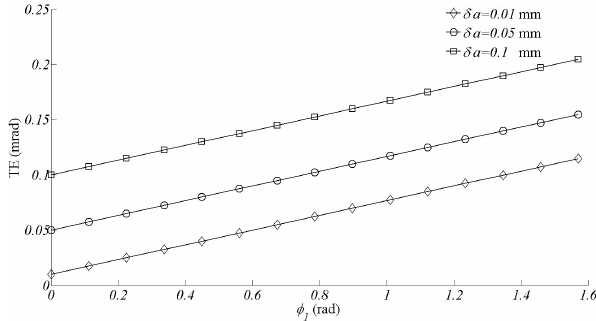
Figure 4. Rotation speed of the driven gear with the speed of driv- ing gear at 600 (rads − 1 ).